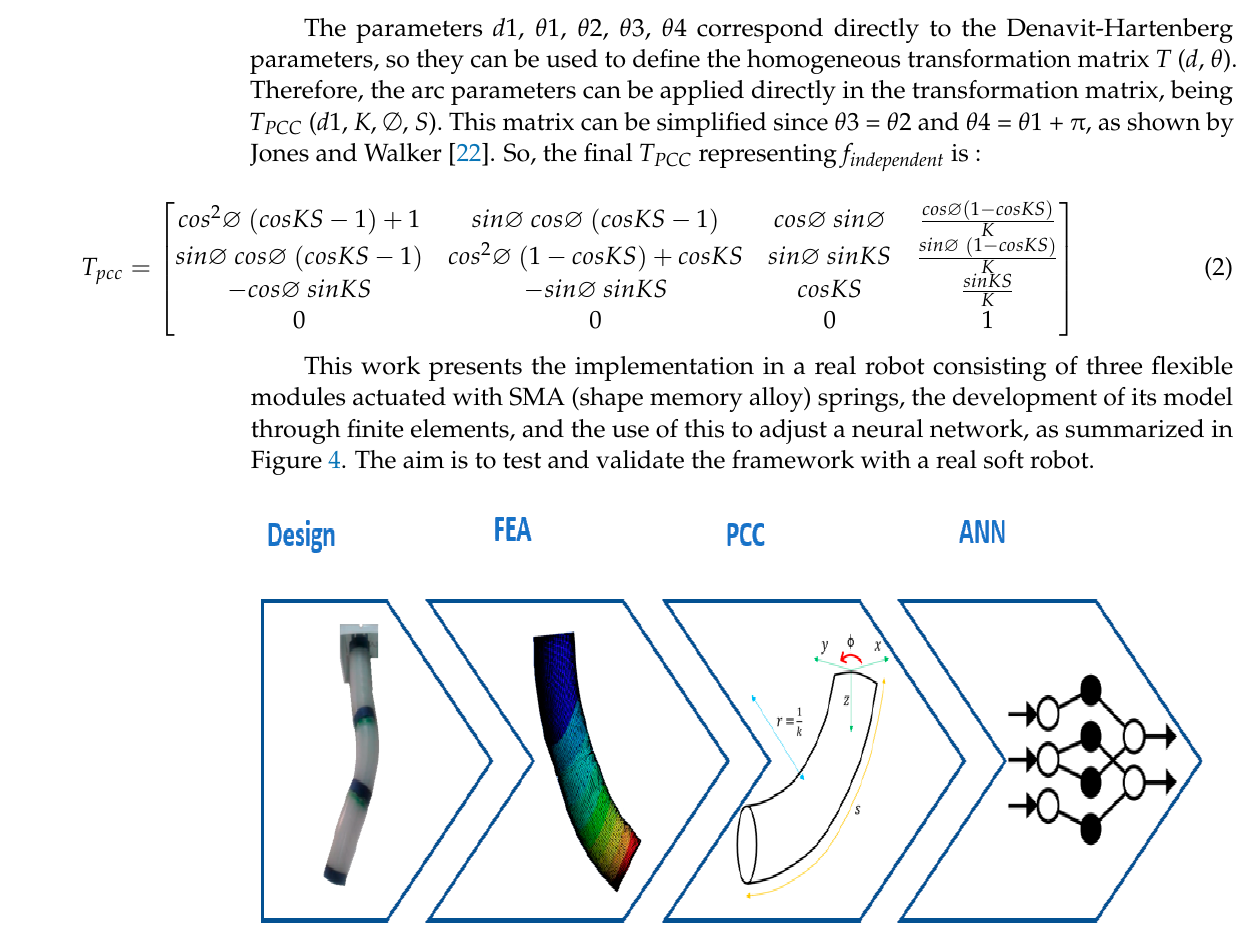
Figure 4. Kinematic modeling and design framework for soft robotic systems. Source: authors.